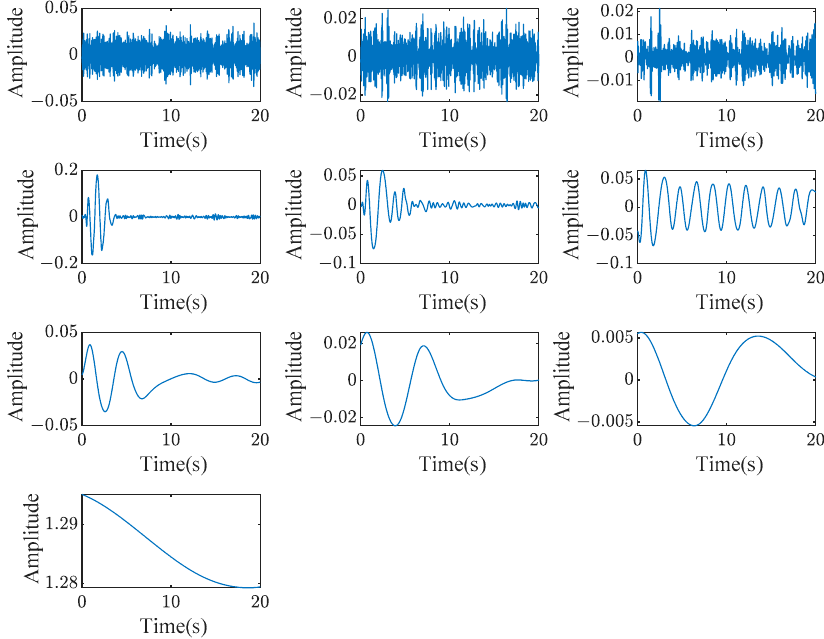
Figure 15. All IMFs and residual of real-time signal decomposed by EMD.